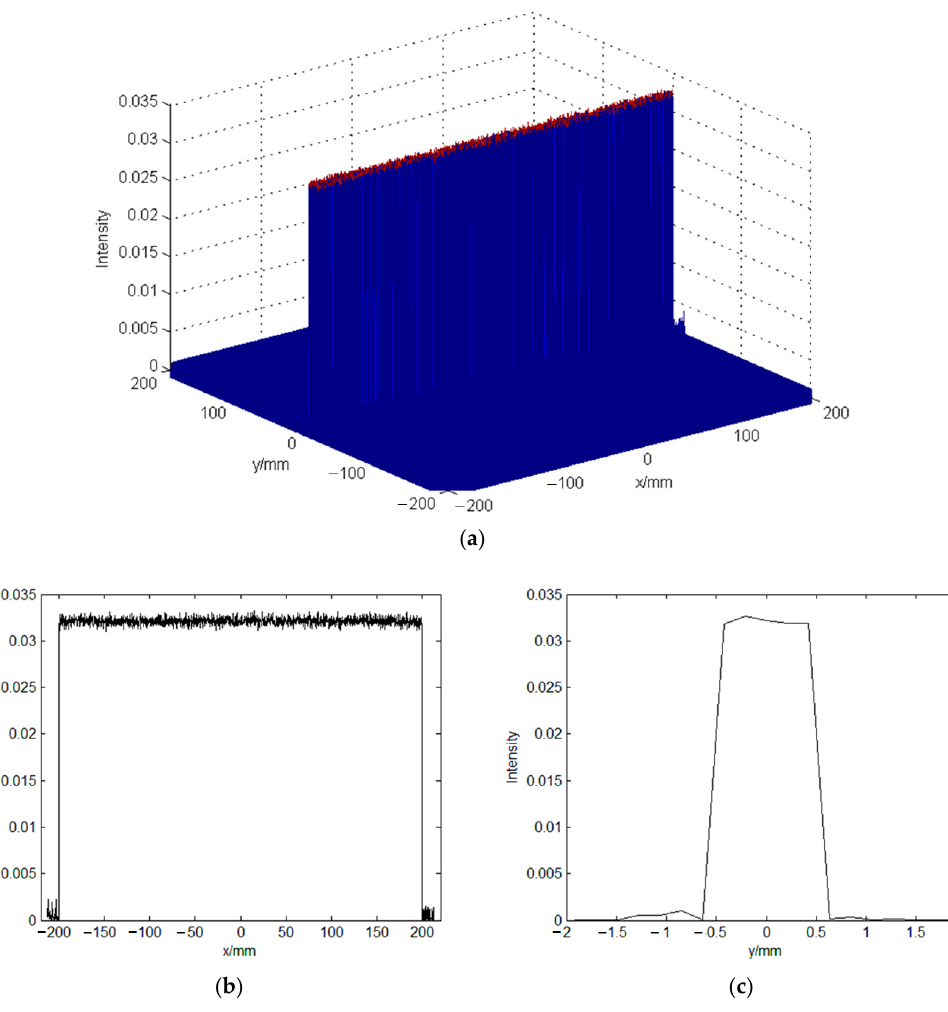
Figure 8. Intensity distribution of the sheet light at Z = 2000 mm. ( a ) Intensity distribution on the image plane; ( b ) intensity distribution along the X axis; ( c ) intensity distribution along the Y axis. Aerospace 2021 , 8 , 393